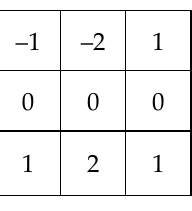
Figure 12. Sobel operator.